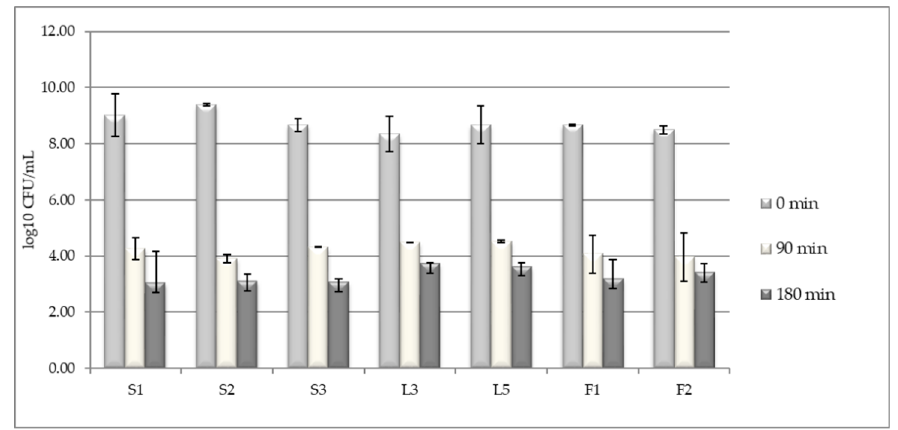
Figure 1. Tolerance of Kombucha lactic acid bacteria (LAB) isolates when cultivating at pH 2.5 and 0.3% pepsin. Data shown are mean ± standard deviation (SD) of triplicate values of independent experiments.